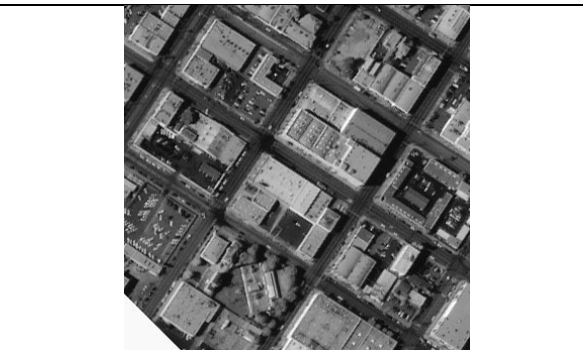
Figure 14: Sub-scenes of used images